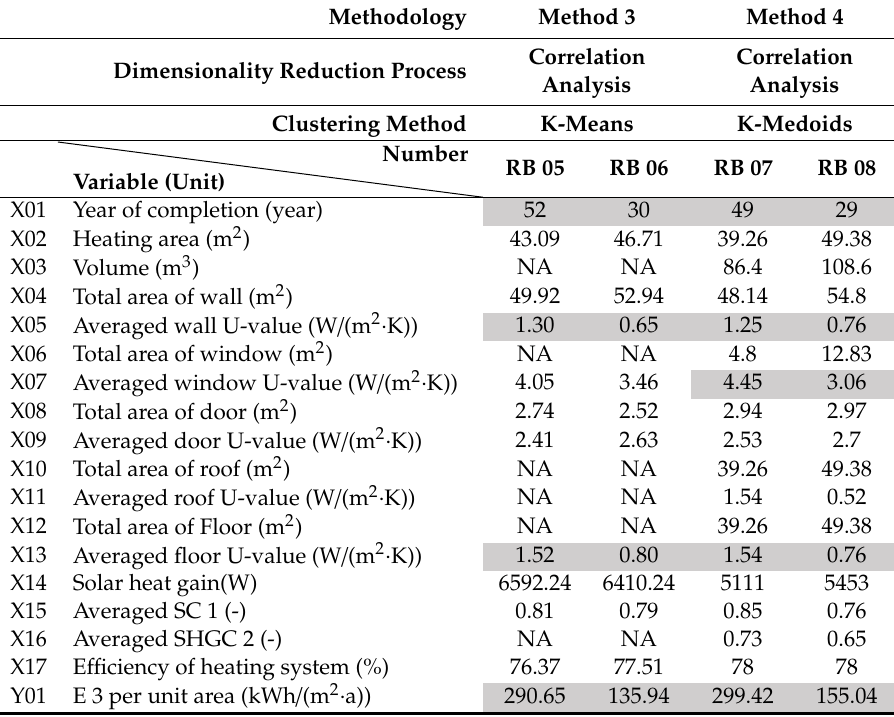
Table 6. Standard model derived through methods 3 and